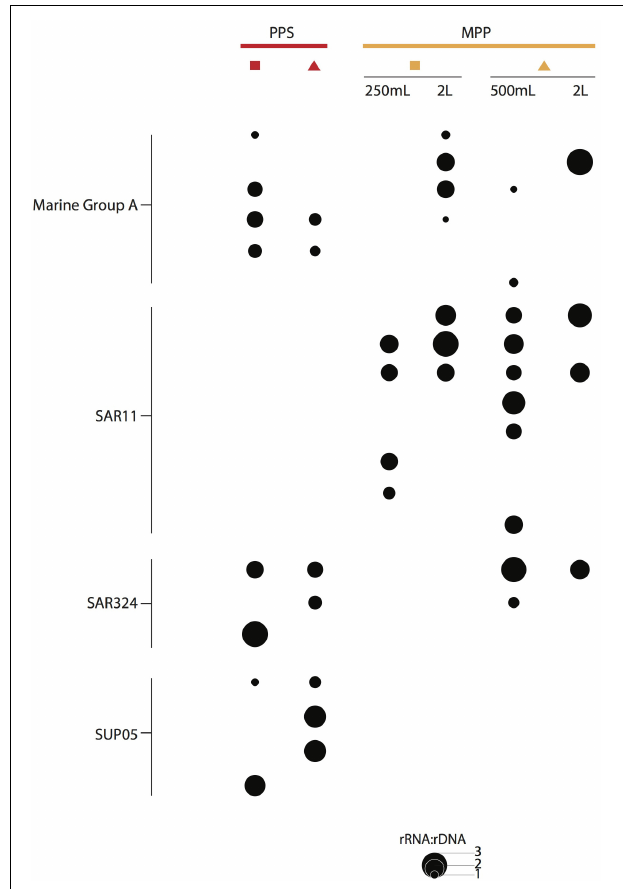
FIGURE 6 | RNA:DNA ratio for abundant and ubiquitous taxa in OMZs, i.e., SUP05, SAR406, SAR11, and SAR324, observed at PPS in situ 0.4 µ m (red) and MPP on-ship 0.22 µ m with in-line 0.4 µ m prefilters (yellow). The size of dots depicts ratio values for individual OTUs as indicated on plot size